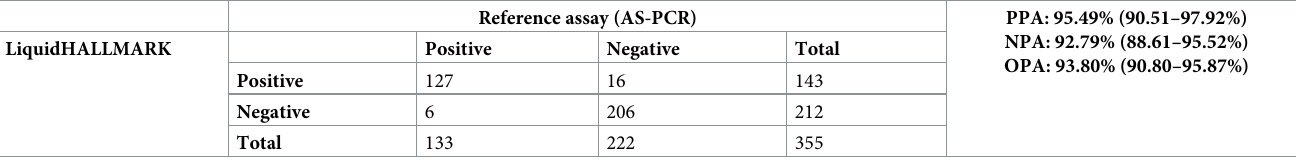
Table 2. Comparison of LiquidHALLMARK with a reference AS-PCR assay for the detection of EGFR L858R, exon 19 deletion, T790M, and uncommon G719X/ L861Q